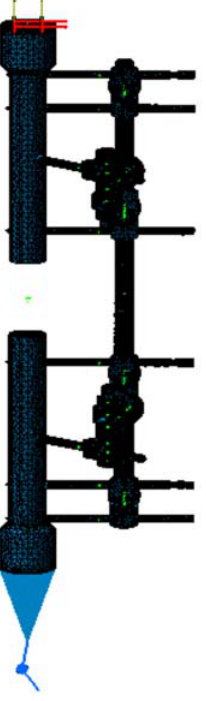
Figure 4. FEM model of external fixation device. Table 2. Mechanical properties of a beech